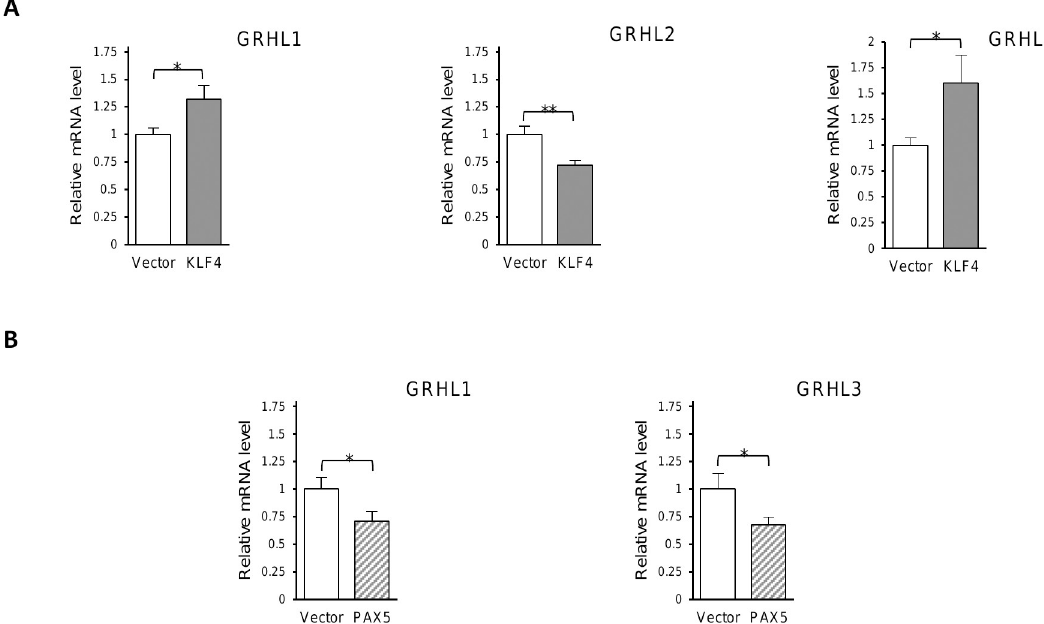
Fig 4. Overexpression of KLF4 or PAX5 alters mRNA levels of GRHL genes. ( A - B ) The mRNA expression levels of GRHL1 , GRHL2 and GRHL3 genes in HEK293 cells transiently overexpressing KLF4 ( A ) or PAX5 ( B ). The results represent relative expression of the respective target gene vs HPRT gene. Data are shown as means ± SEM of experiments independently performed in triplicate, � significantly different at p � 0.05, �� significantly different at p �